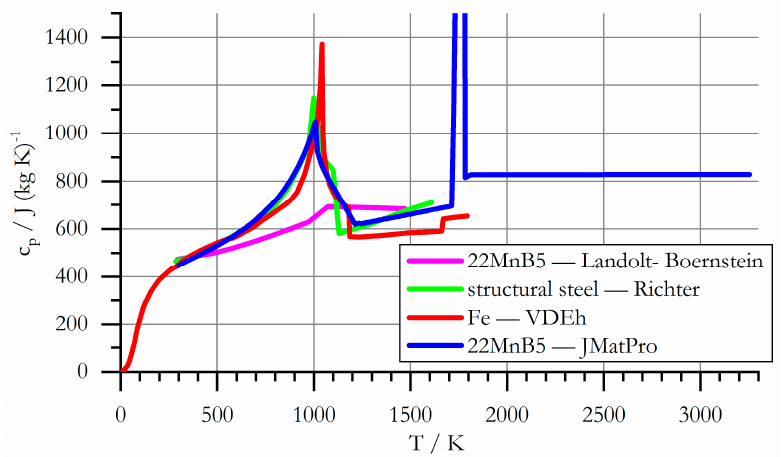
Figure 11. Specific heat capacity of 22MnB5.